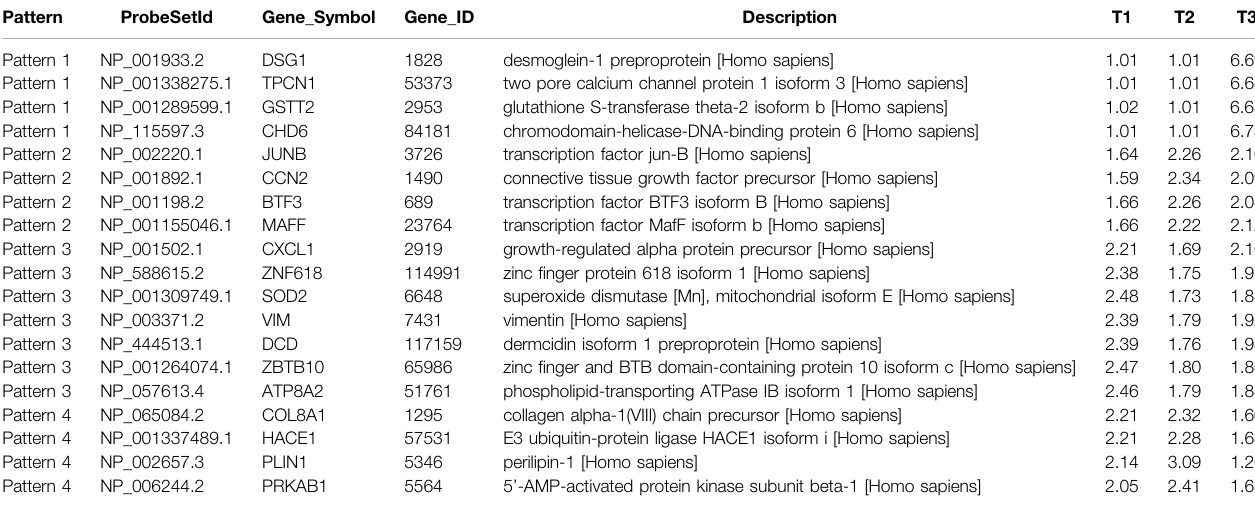
TABLE 1 | Downstream candidates of CMCs in HTM adapting to mechanical